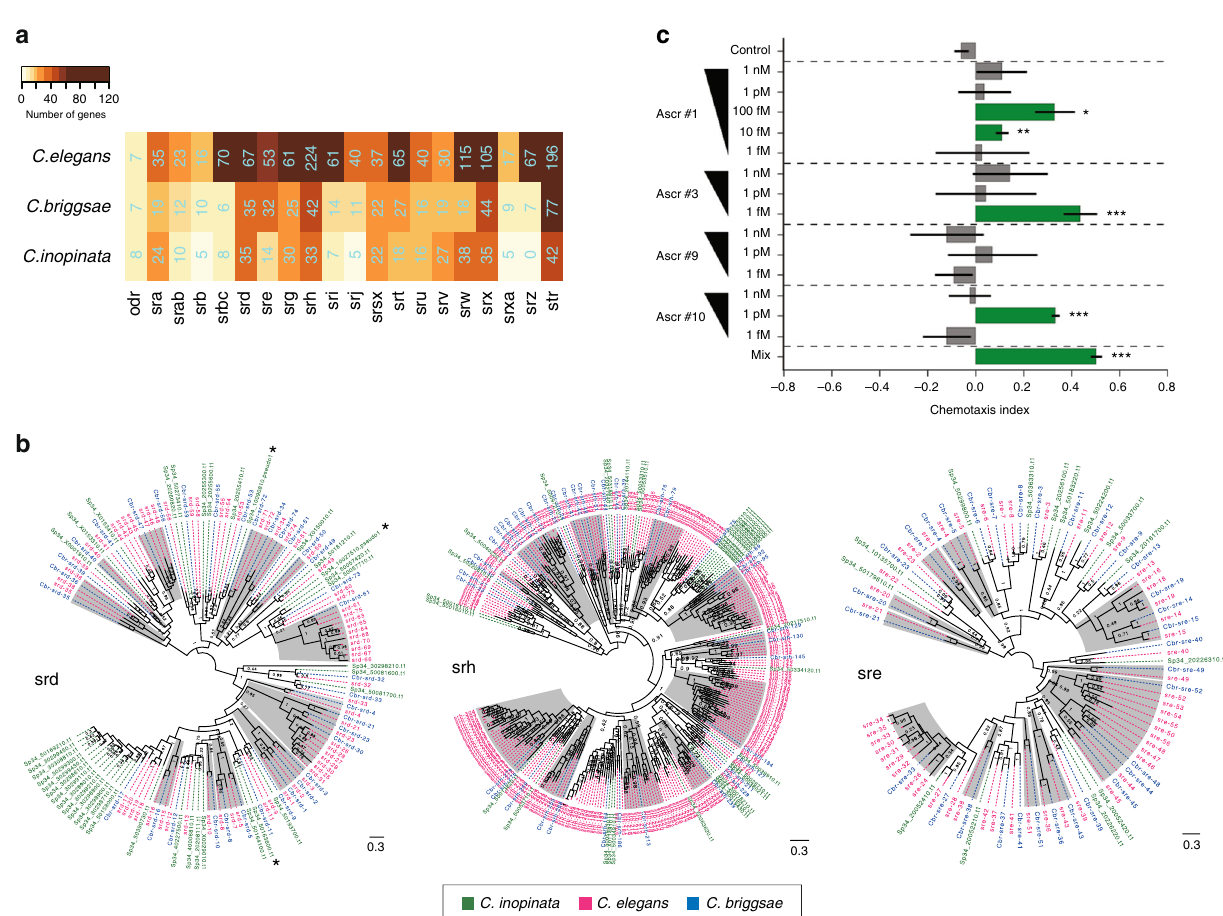
Fig. 4 Diversity of 7TM GPCR gene families in C. inopinata and chemosensory response. a A heat map showing gene numbers of 7TM GPCR (serpentine) gene families in C. inopinata , C. elegans , and C. briggsae . b Maximum likelihood trees of srd , sre , and srh serpentine families of the three Caenorhabditis species showing gene losses, as well as local gene expansions in C. inopinata . Clusters with gene loss in the C. inopinata genome were shaded in grey. c Response of C. inopinata males to synthetic ascarosides produced by mixed stage cultures. CI chemotaxis index. Ascr#, refer to distinct synthetic ascarosides that are made by C. inopinata . The bars represent the mean CI and the whiskers are the SEM. The green-coloured bars indicate ascaroside concentrations that were signi fi cantly different from the